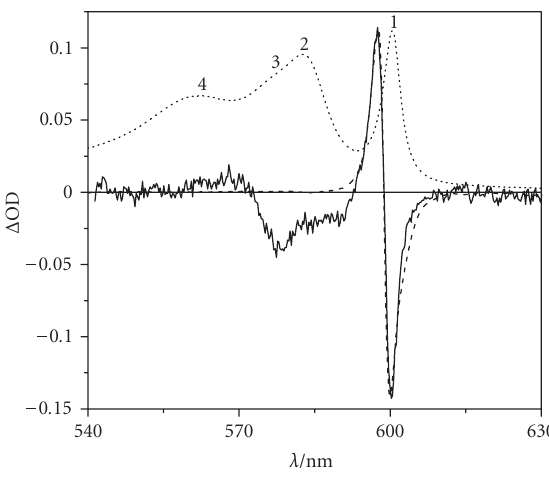
Figure 4: Scaled zero-delay pump-probe spectra of pure C8O3 ag- gregates at 600 nm excitation, with the polarization of the probe beam parallel (dashed line), and perpendicular (solid line) to the flow. The dotted line shows the isotropic linear absorption spec- trum for